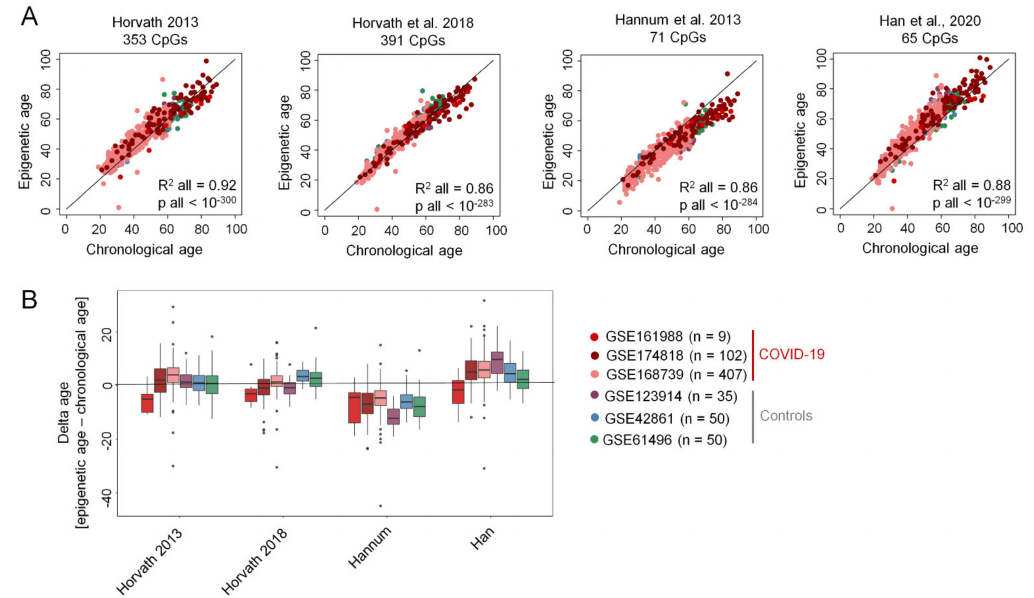
Figure 1. Epigenetic ageing clocks based on Illumina BeadChip data are not accelerated in COVID-19 patients. ( A ) Genome wide DNA methylation profiles of COVID-19 patients from three different studies (GSE161988; GSE174818; and GSE168739), as well as 135 controls of healthy donors of three studies (GSE123914, GSE42861; GSE61496) were analyzed with four different predictors of epigenetic age as described by Horvath 2013 [13], Horvath et al. 2018 [14], Hannum et al. 2013 [15], and Han et al. 2020 [16]. For all datasets combined, the coefficient of determination (R 2 ) and the regression p value are indicated for each predictor. ( B ) Boxplots present the deviation of epigenetic age prediction and chronological age (delta-age). Significance of pairwise comparisons is provided in the Supplementary Figure S3.